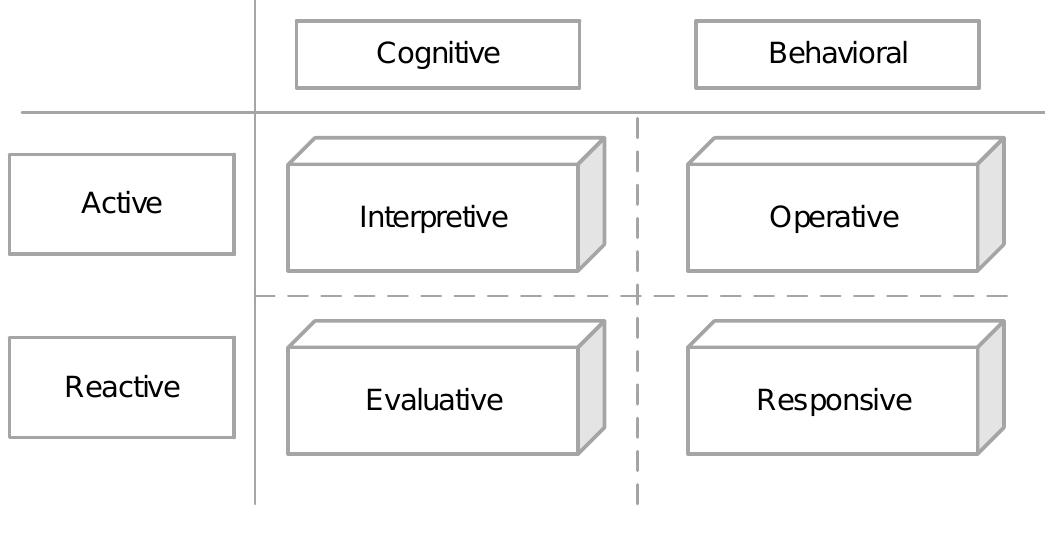
Figure 1. Modes of human-environment transactions from the perspective of environmental psychology